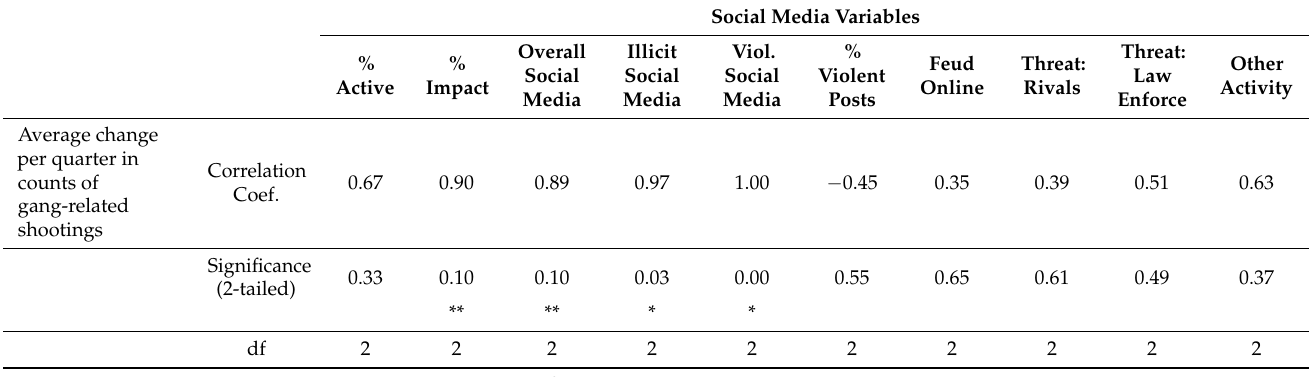
Social Media Variables Overall Illicit % Threat: % % Feud Threat: Other Social Social Violent Law Active Impact Online Rivals Activity Media Media Media Posts Enforce